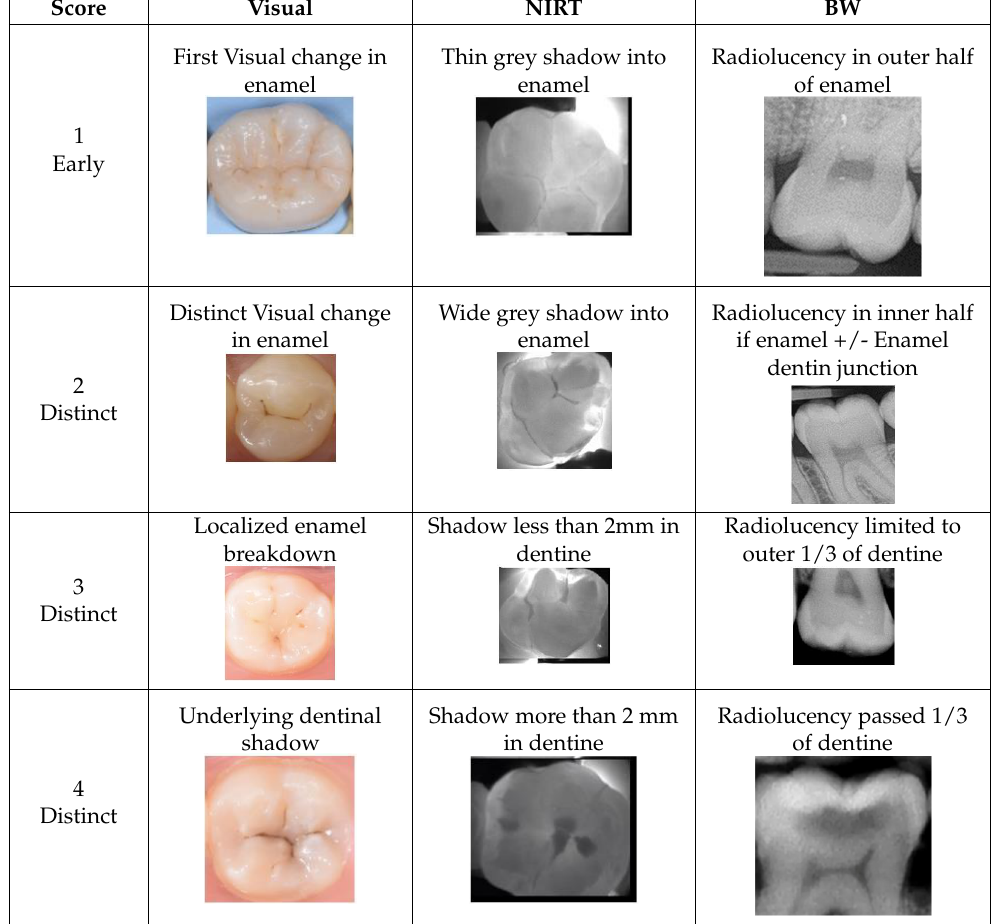
Table 1. Scoring System of the three detection methods used in this study (adapted from Gomez et al. 2015 [34]). Visual evaluation using ICDAS based on clinical images (CI), near-infrared transillu- mination (NIRT), and bitewing radiographs (BW) were scored into 5 categories as described above. Score 1 was considered as early lesions while scores 2, 3 and 4 were considered as distinct lesions.